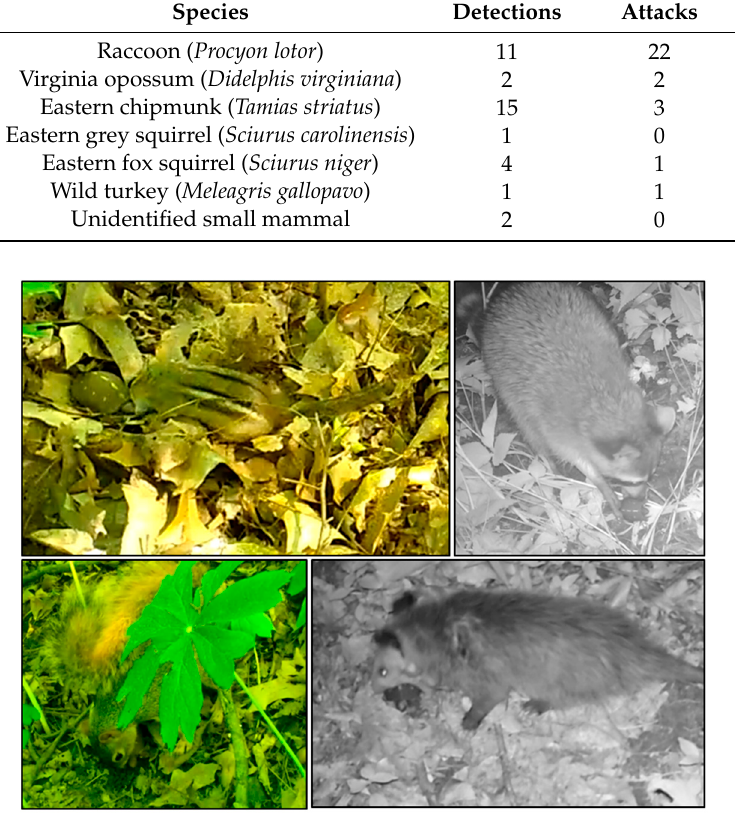
Figure 3. Still images from trail camera videos showing interactions with three-dimensional printed turtle models by mammalian predators. Clockwise from top-left: eastern chipmunk ( Tamias striatus ), raccoon ( Procyon lotor ), Virginia opossum ( Didelphis virginiana ), and eastern fox squirrel ( Sciurus niger ).